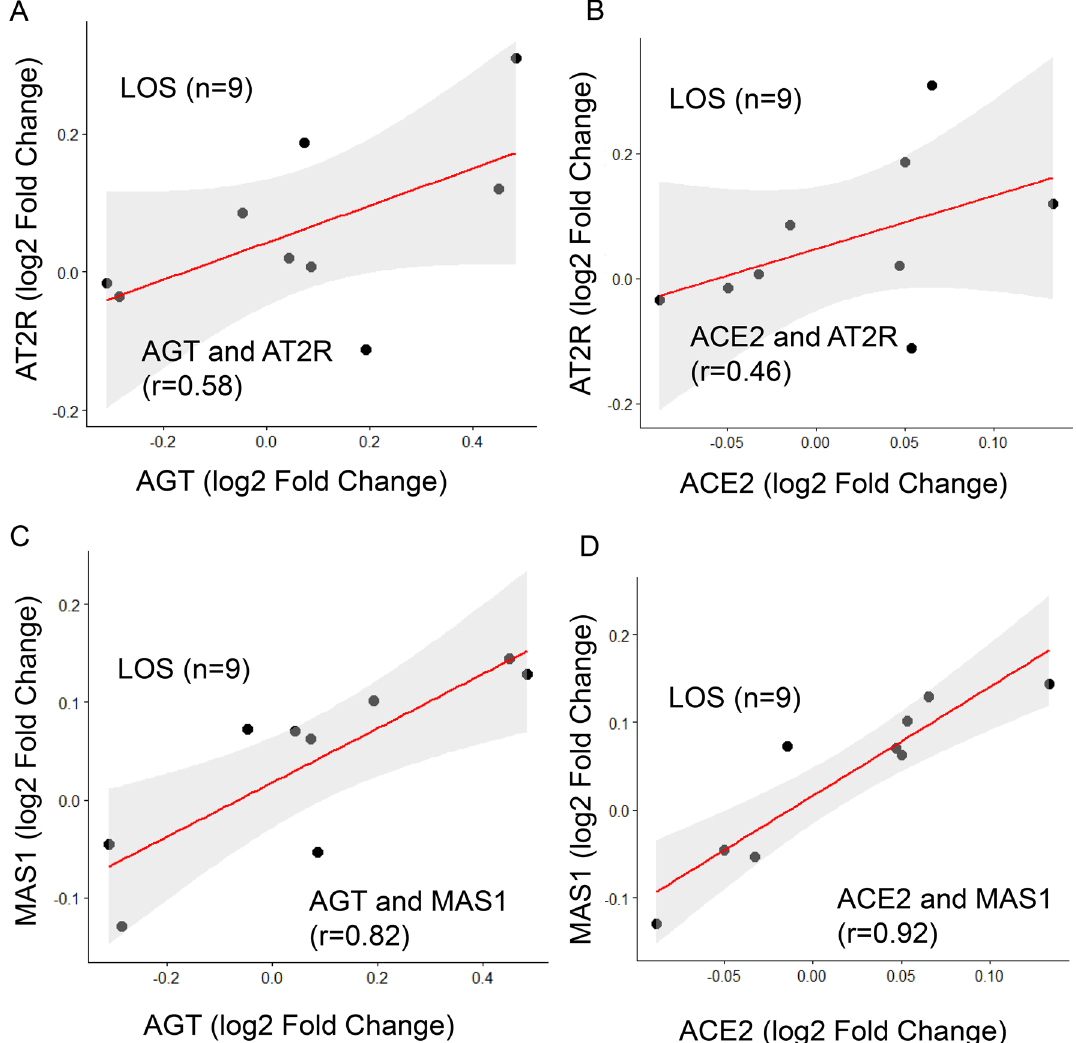
Figure 4. Positive Pearson correlation of RAS component to LOS treatment. ( A ) Positive correlation of AGT with AT2R (r = 0.58). ( B ) Positive correlation of ACE2 with AT2R (r = 0.46). ( C ) Positive correlation of AGT with MAS1 (r = 0.82, ***P < 0.001). ( D ) Positive correlation of ACE2 with MAS1 (r = 0.92, ***P < 0.001). Calculation of correlation coefficient and testing the significance of the correlation coefficient were performed using R (* denotes P <